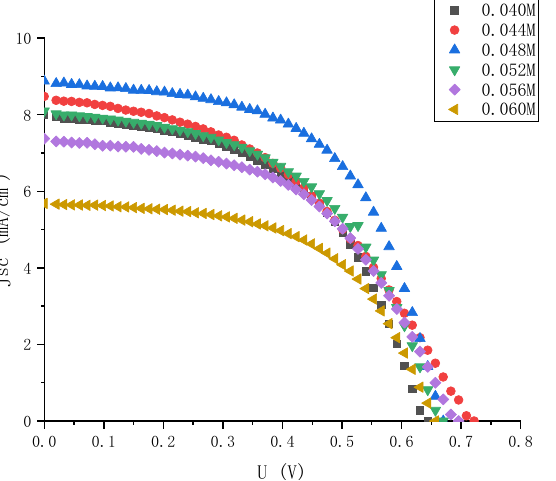
Figure 8. Fitting curve of short circuit current density at different electrolyte concentrations.